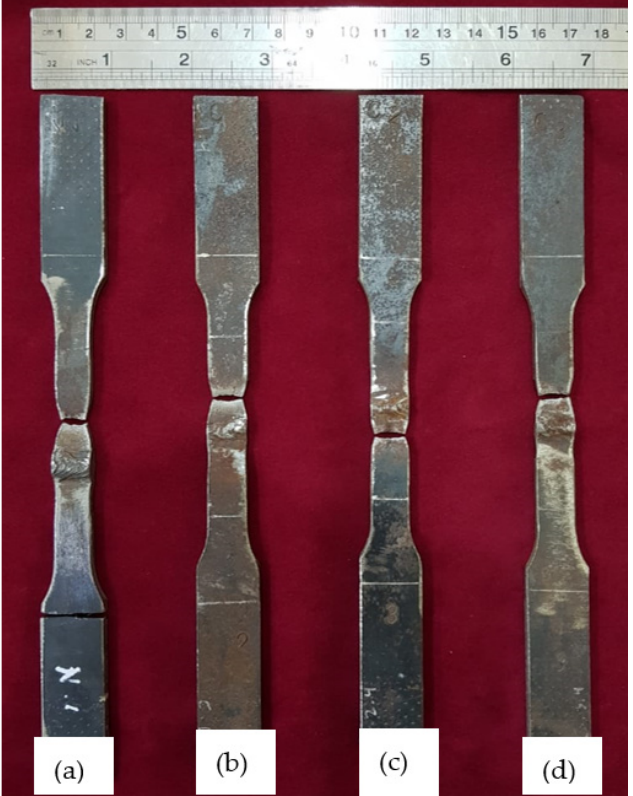
Figure 20. Photos of tensile strength test results on welded specimens ( a ) land-based welding, ( b ) without flow, ( c ) with the non-uniform flow and a baffle plate, ( d ) with the non-uniform flow without a baffle plate.